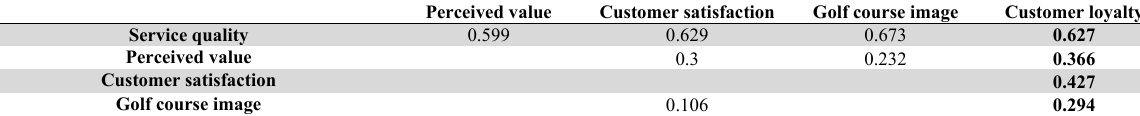
Total effects of factors on customer